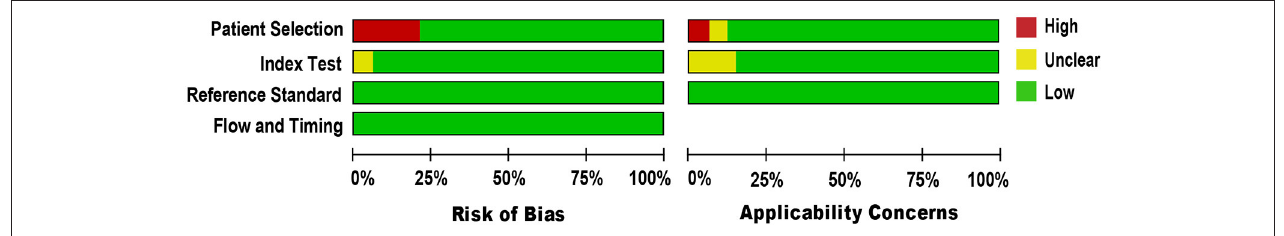
FIGURE 2 | Methodological quality and risk of bias assessment of the eligible studies.